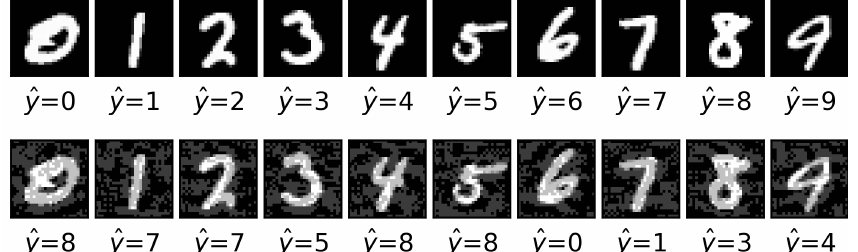
Figure 5. Ten MNIST examples ( top ) and their perturbations ( bottom ). Predicted class shown for each